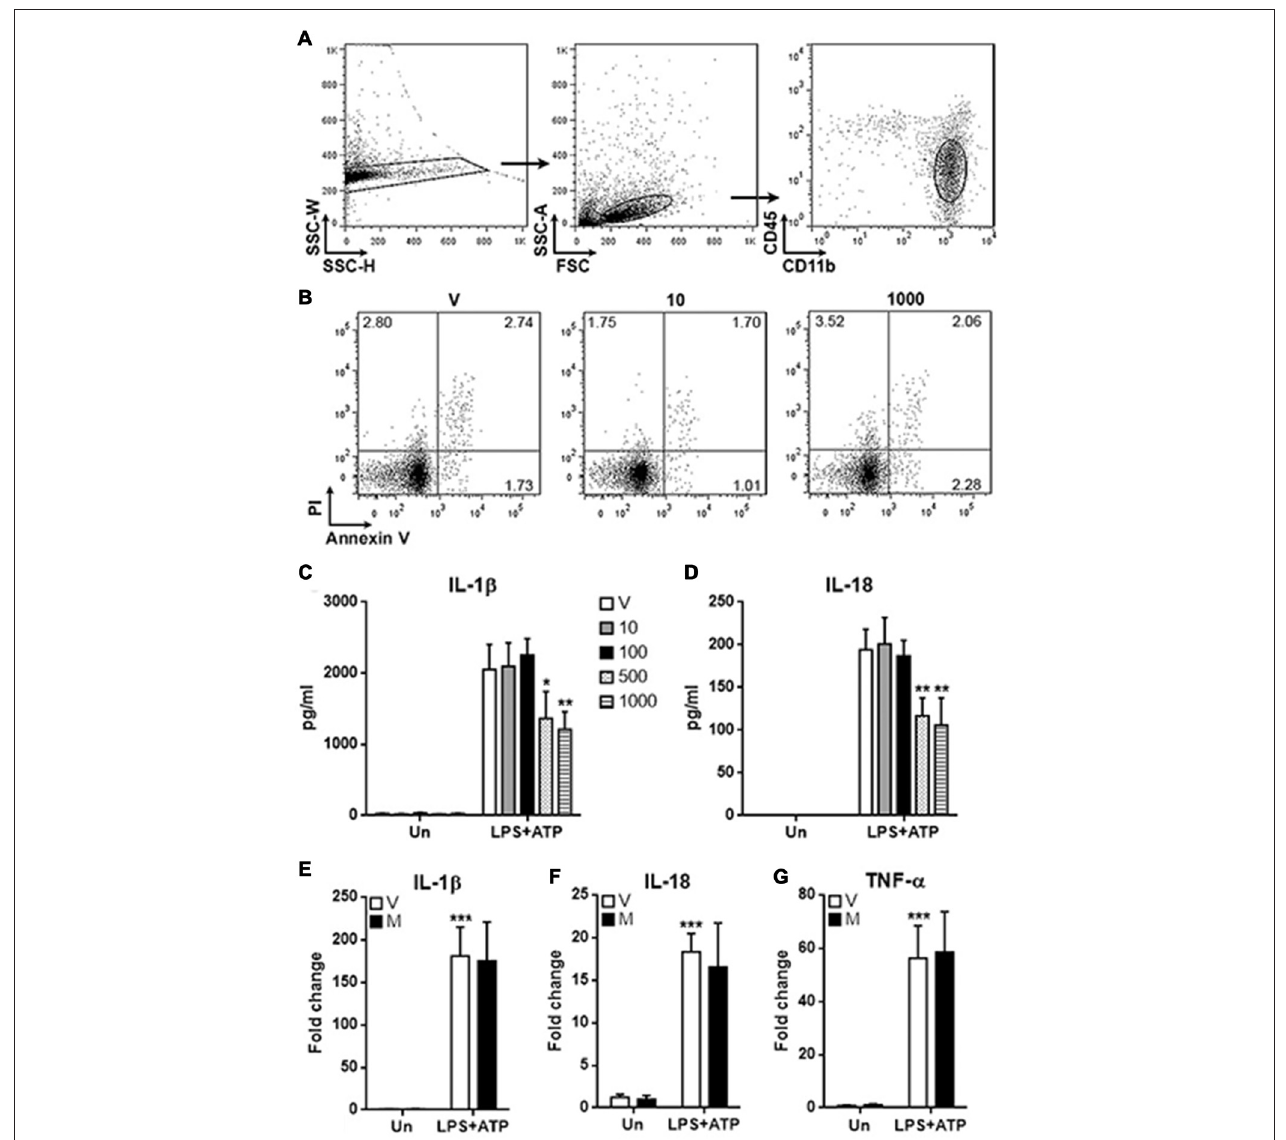
FIGURE 1 | Methylene blue inhibits the production of mature IL-1 β and IL-18 by microglia. (A) Gating strategy for distinguishing and sorting microglia form normal rat spinal cords. CD45 low CD11b + cells were microglia. N = 3 per group. (B) Apoptosis of microglia cultured for 48 h. V: vehicle phosphate buffered saline (PBS); 10: 10 nM methylene blue; 1000: 1000 nM methylene blue. Numbers in the quadrats are percentage of each gated population. N = 3 per group. (C,D) Concentrations of IL-1 β and IL-18 in the supernatants. Un: no stimulation. lipopolysaccharide (LPS) + adenosine triphosphate (ATP): stimulation with LPS followed by ATP treatment. V: vehicle; 10 ∼ 1000: methylene blue concentrations (nM). ∗ p < 0.05; ∗∗ p < 0.01 in comparison with stimulated cells of the vehicle group. (E–G) mRNA levels of IL-1 β , IL-18 and TNF- α in cultured microglia. V: vehicle; M: 500 nM methylene blue. ∗∗∗ p < 0.001 in comparison with unstimulated cells of the vehicle group. N = 6–8 per group.